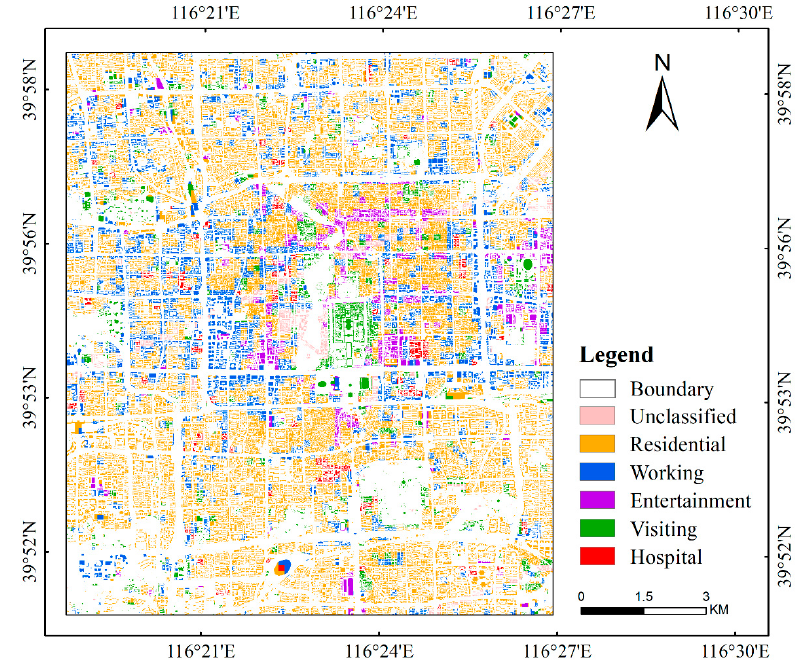
Figure 16. RF model-predicted BFT map for the study area.